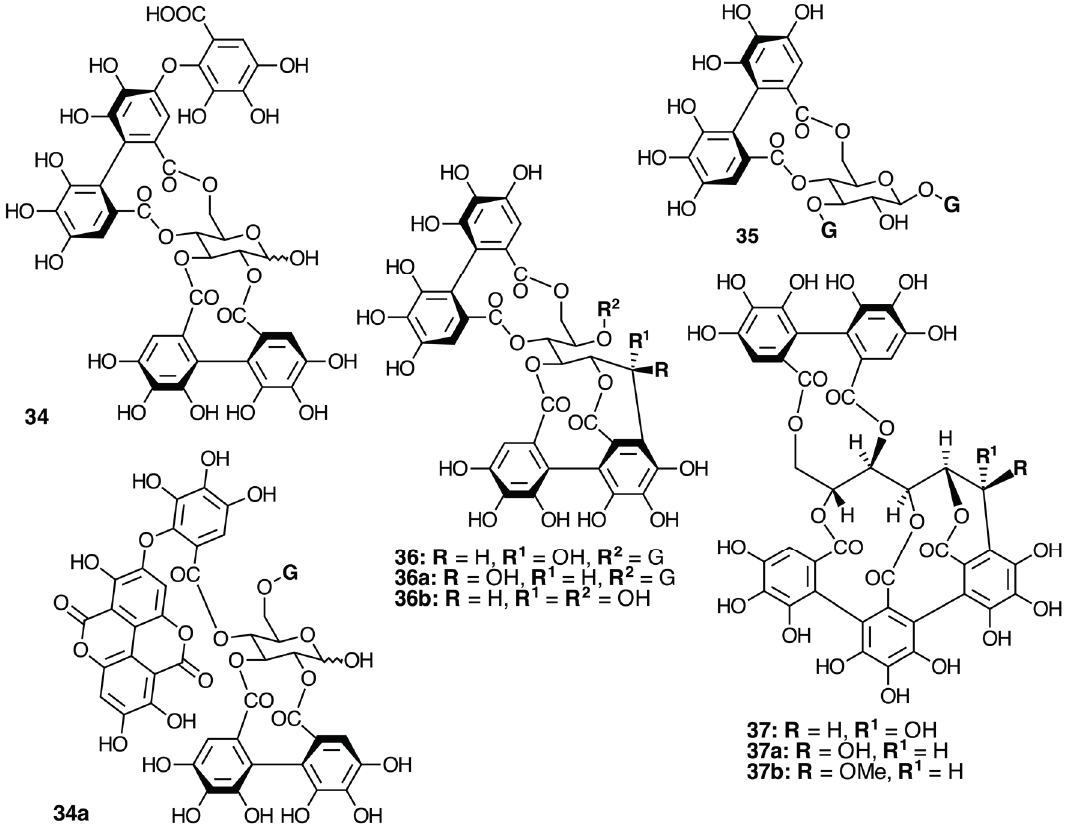
Figure 12. Modified and C -glucosidic monomeric